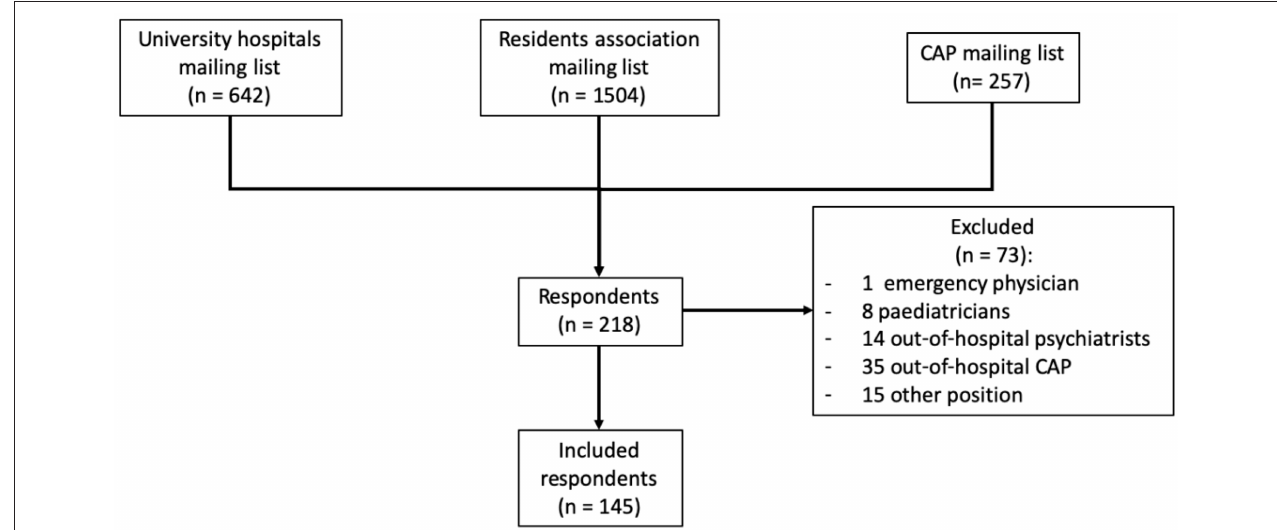
FIGURE 1 | Flow chart of study